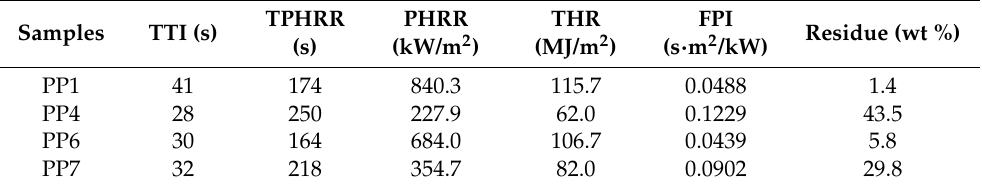
Table 5. Characteristic parameters of the CCT (cone calorimetric test) for PP and PP